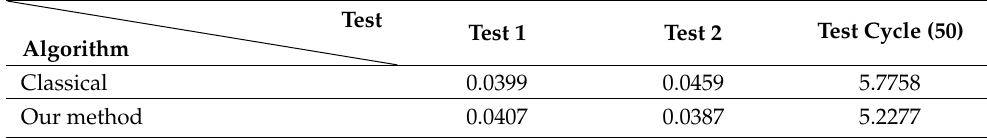
Figure 10. k value of KNN algorithm (with feature selection). Table 5. Experimental results of proposed